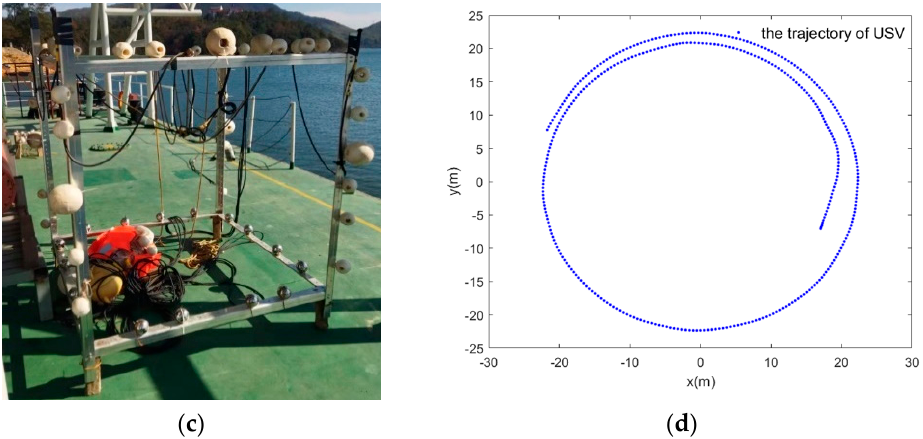
Figure 8. Experimental scenario and setup of circular array synthetic aperture sonar. ( a ) The schematic of CASAS installation in USV. It also shows the Navigation devices of USV, such as RTK GPS and INS. ( b ) The photo shows that the CASAS was installed in USV and the transmit and receive array side of CASAS perpendicular to the movement direction of USV during the trial. ( c ) The photo of the steel cube which was treated as experiment target. ( d ) The trajectory of USV in experiment which was recorded by GPS.